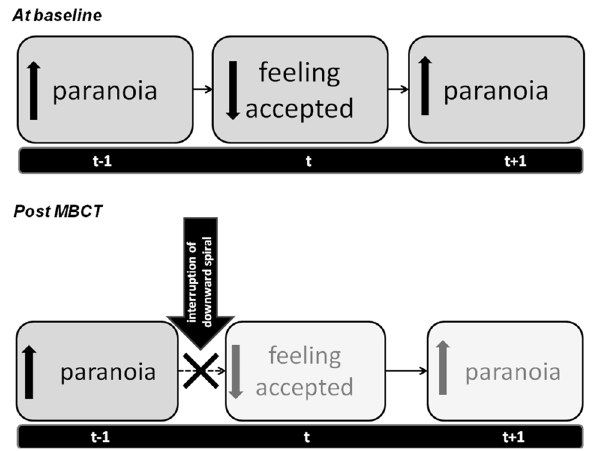
Figure 1. Time-lagged associations between feeling paranoid and feeling accepted in the flow of daily life: baseline and post- Mindfulness-based cognitive therapy (MBCT).